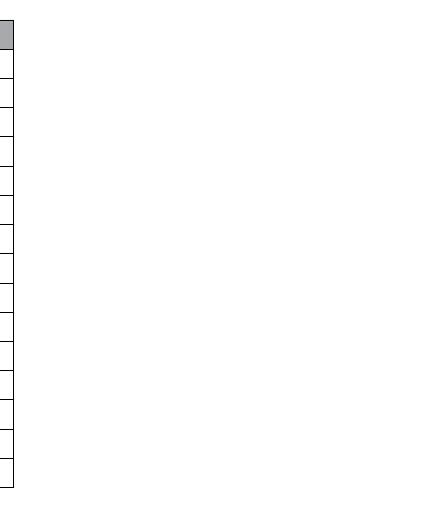
Table 3. Perioperative outcome according to disease